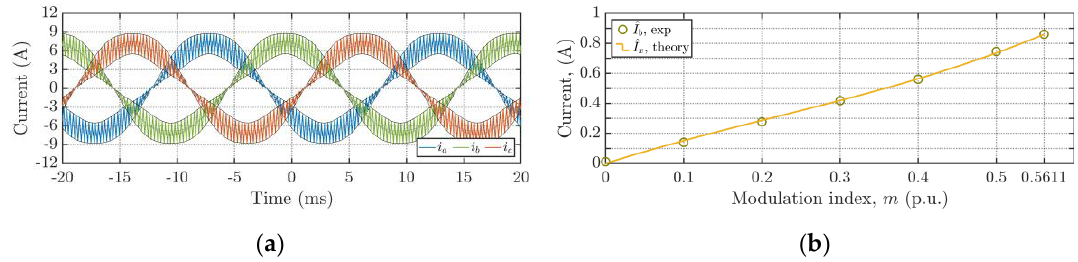
Figure 36. ( a ) Phase currents with primary (black) and secondary (gray) envelopes in case of Figure36. ( a )Phasecurrentswithprimary(black)andsecondary(gray)envelopesincaseofTHIPWM1 / 4 √ √ THIPWM1/4 ( m = 6√3/(7√7)); ( b ) Phase current ripple rms in case of THIPWM1/4. ( m = 6 3 / (7 7)); ( b ) Phase current ripple rms in case of THIPWM1 / 4.